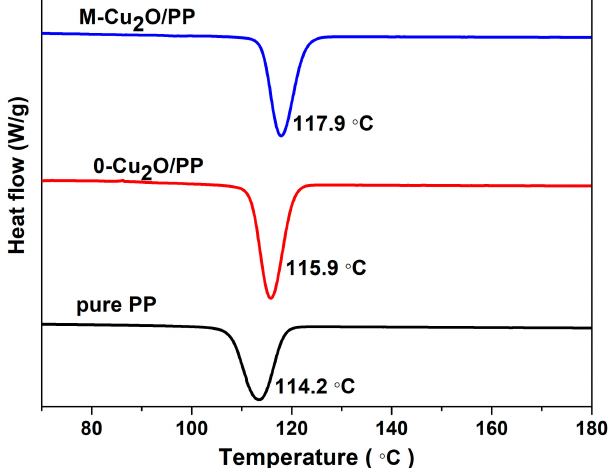
Figure 8. Cooling curves of pure polypropylene (PP) and Cu 2 O / PP